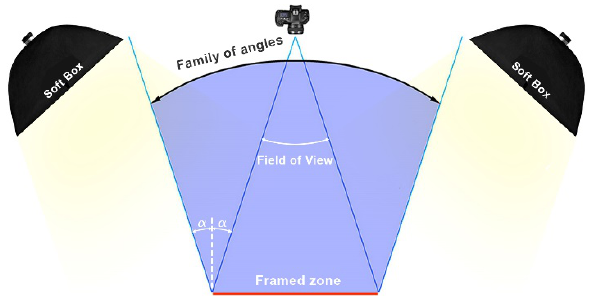
Figure 4 . Placement of the lights out of the volume defined by the family of angles that would produce specular